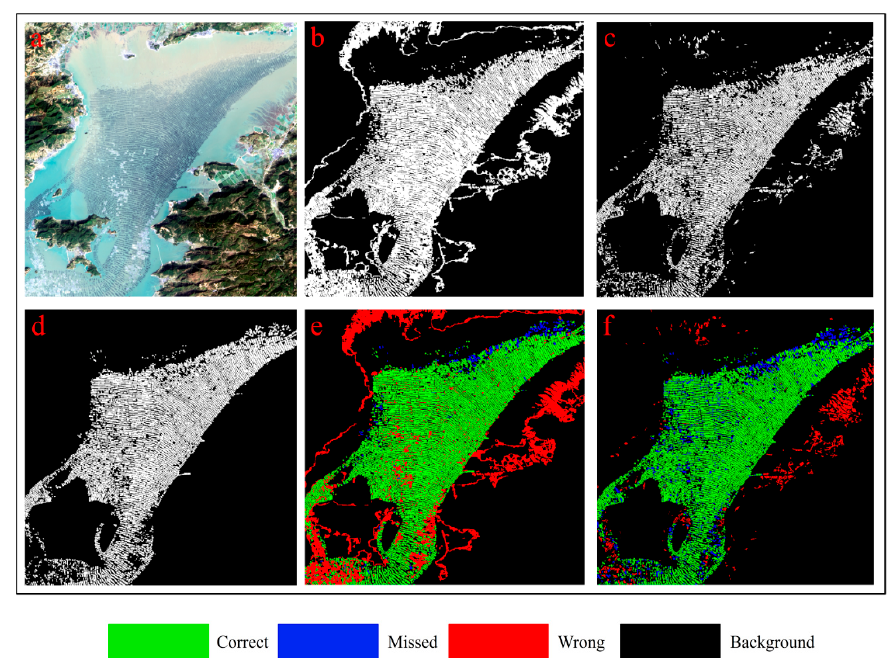
Figure 7. Results of two experimental methods for study area 3: ( a ) Initial image; ( b ) OBVS-NDVI extraction result; ( c ) Proposed extraction result; ( d ) Human interpretation result; ( e ) Overlap of OBVS-NDVI result with human interpretation result; ( f ) Overlap of proposed result with human interpretation result. Table 2. Accuracy evaluation results of the three study areas. Study Area Method Recall (%)